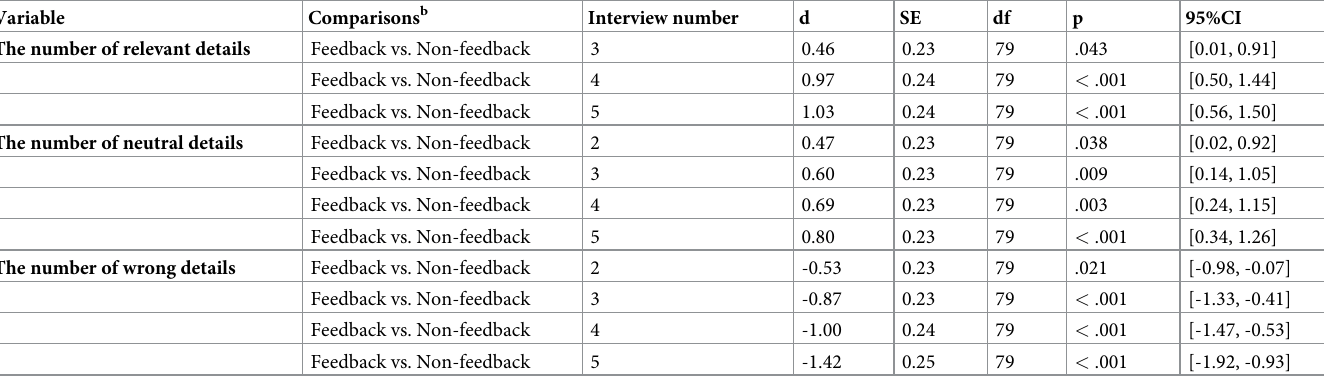
Table 5. a The individual effect of the HT or feedback intervention on the types of details over time.